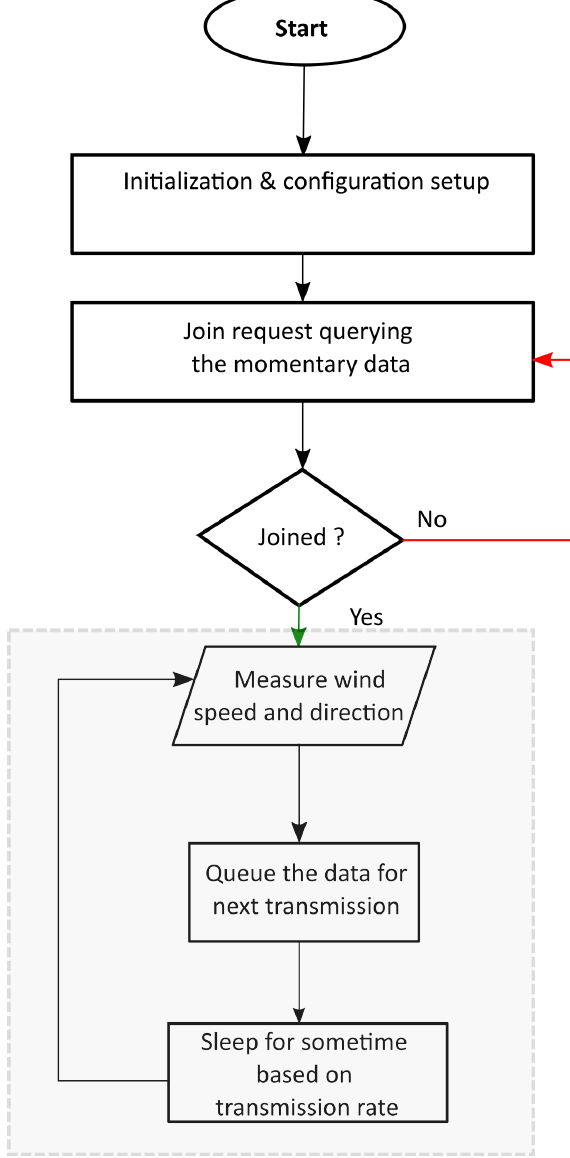
Figure 4. Basic algorithm for wind data